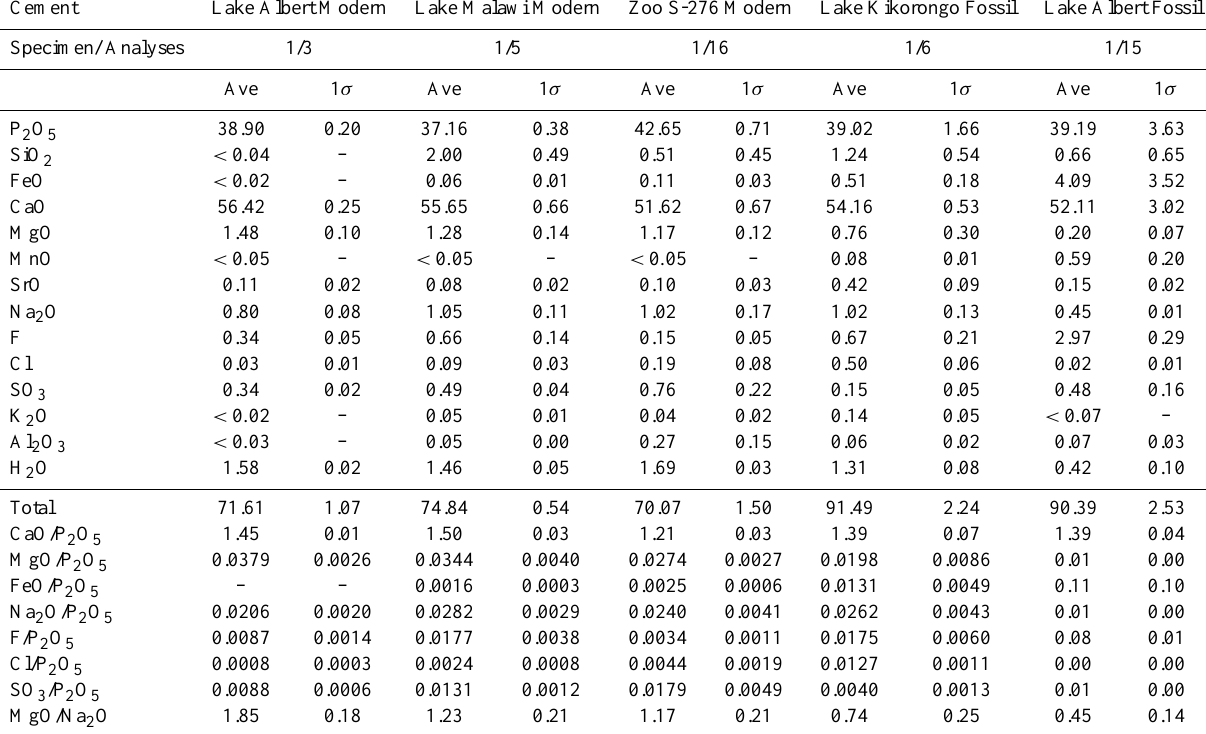
Table 3. Average chemical composition of cement from modern and fossil hippopotamid molar teeth. Cement Lake Albert Modern Lake Malawi Modern Zoo S-276 Modern Lake Kikorongo Fossil Lake Albert Fossil Specimen/